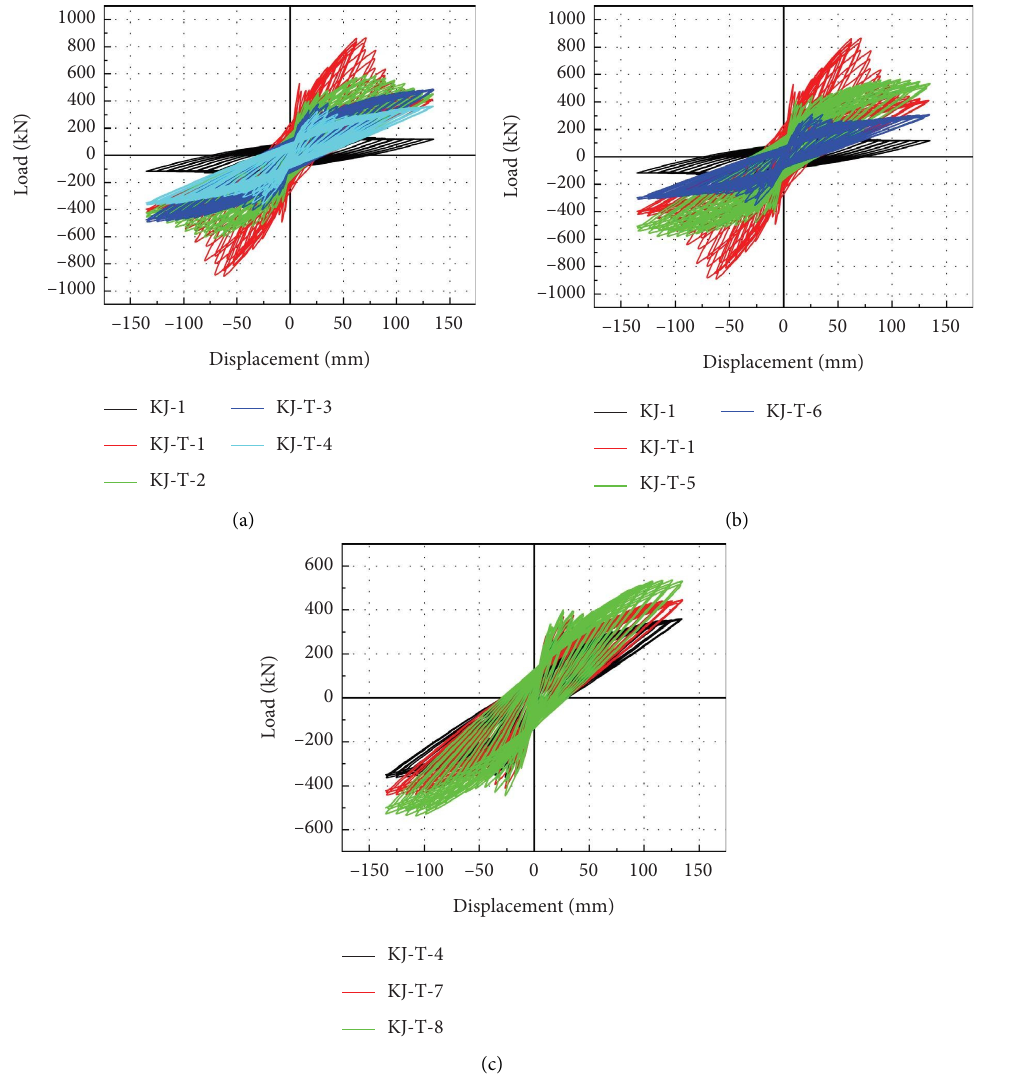
Figure 12: /e effect of different parameters on hysteretic curve. (a) /e effect of opening rate. (b) /e effect of the infill falls position. (c) /e effect of the block